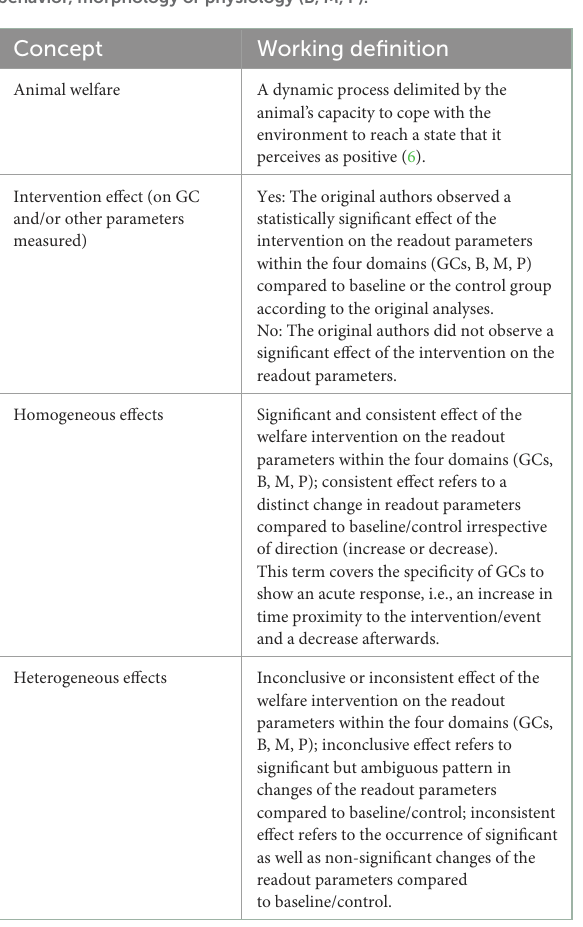
TABLE 1 Conceptual approach to animal welfare underlying the selection of studies included in this mapping review and categorization of parameter outcomes within the four domains GCs, behavior, morphology or physiology (B, M,